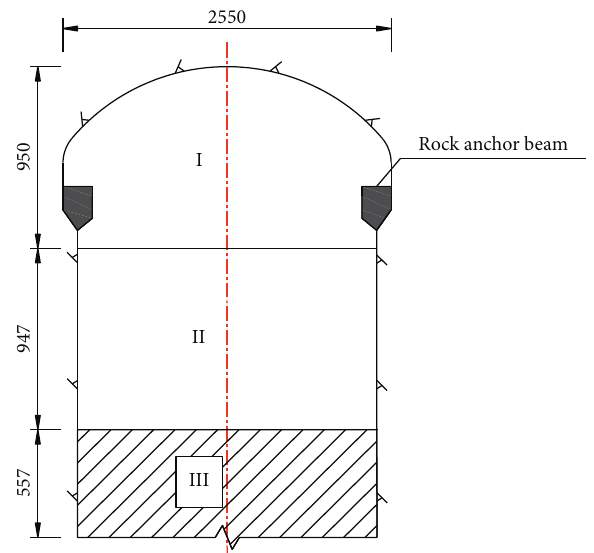
Figure 5: Layered excavation of underground powerhouse (unit: